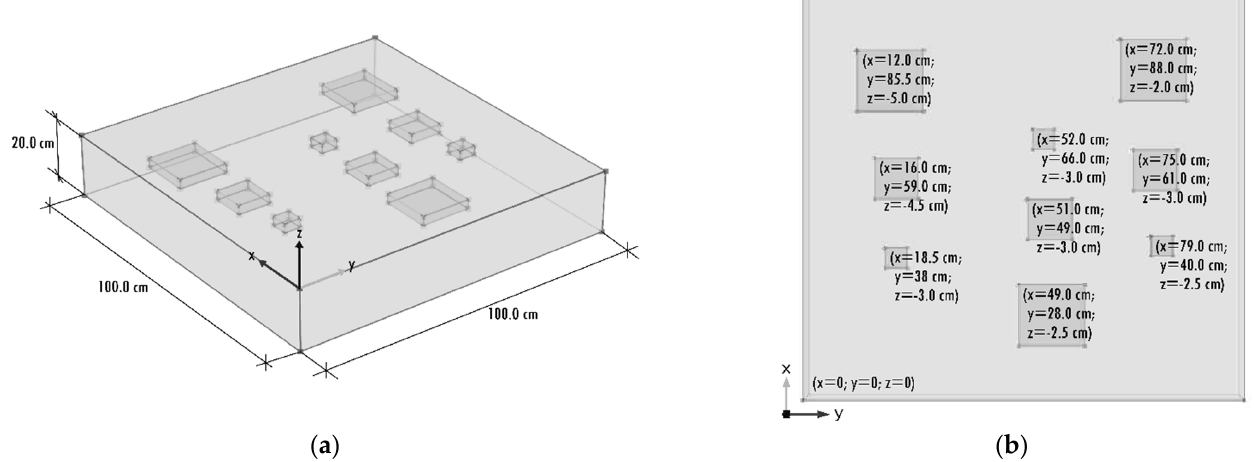
Figure 1. Concrete sample with artificial subsurface delamination: ( a ) 3D view; ( b ) coordinates of the fabricated damages.